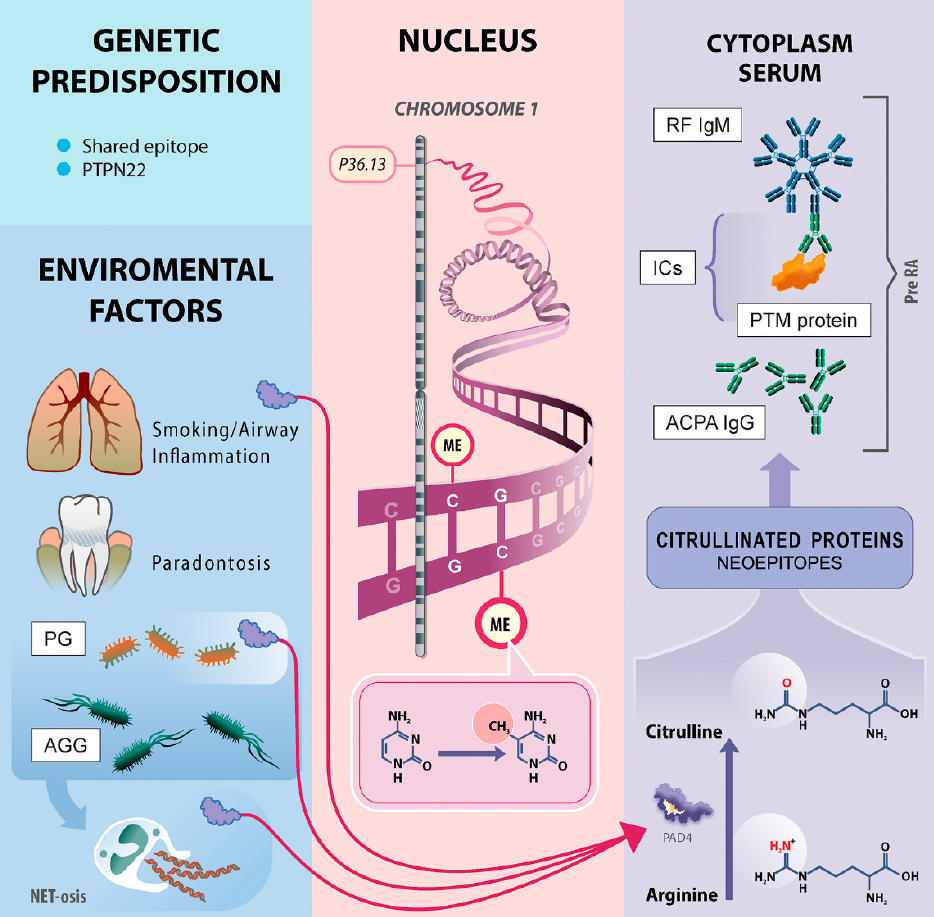
Figure 4. Pathways to RA development. The individuals with genetic predisposition (MHC—shared epitope, SNP of PTPN22) exposed to environmental factors (smoking, airway inflammation, periodontitis) have developed a shift in PADI4 gene methylation degree. The airway inflammation and smoking are connected with higher PAD activity [40]. NET-osis is a PAD4-dependent mechanism used during the host immunological response against exogenous bacteria like PG and ACC [41–43]. Additionally PG is a bacteria with its own PAD4 activity [44]. The dysregulation of PAD4 gene expression via methylation depends on the environmental impact on the mouth and lungs leading to elevated expression of PAD4 enzyme and increased conversion of arginine to citrulline in various proteins, leading to a loss of tolerance to citrullinated proteins and APCA synthesis. The ICs of citrullinated proteins and ACPA IgG become an antigen to RF production. After a period of ACPA and/or RF positivity called pre-RA and unknown “second hit”, the development of arthritis/synovitis is influenced in patients. Abbreviations: PG, Porphyromonas gingivalis ; AGG, Aggregatibacter actinomycetemcomitans ; ME, methylation; ICs, immunological complexes; ACPA, anti-citrullinated protein antibodies; PTM, proteins post-translationally modified proteins; PAD4, peptidyl arginine deiminases type 4; RF, Rgeumatoid Factor; Pre RA, pre-Rheumatoid Arthritis; PTPN22, Protein tyrosine phosphatase, non-receptor type 22, NET-osis Neutrophil extracellular traps activation and release.